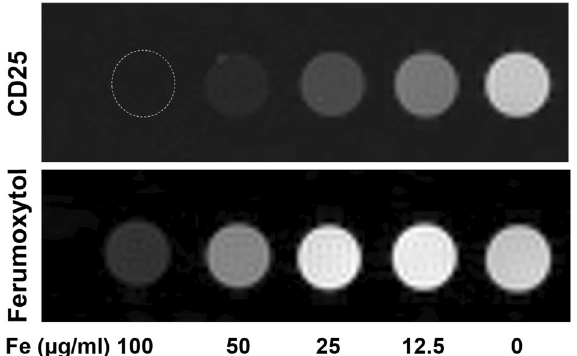
Figure 1. Magnetic resonance signal effects of CD25 microbeads compared to ferumoxytol. T2-weighted magnetic resonance images of agarose gels (200 µl) containing increasing contrast agent concentrations (0, 12.5, 25, 50 or 100 µg/ml of CD25 microbeads or ferumoxytol) show marked signal decrease (dark) for both contrast agents compared to controls (0 = agarose gel alone). Signal decay is more pronounced for CD25 microbeads compared to ferumoxytol. Data was acquired on a 7 T MRI with 10 TEs equally spaced from 6.4 to 64 ms.